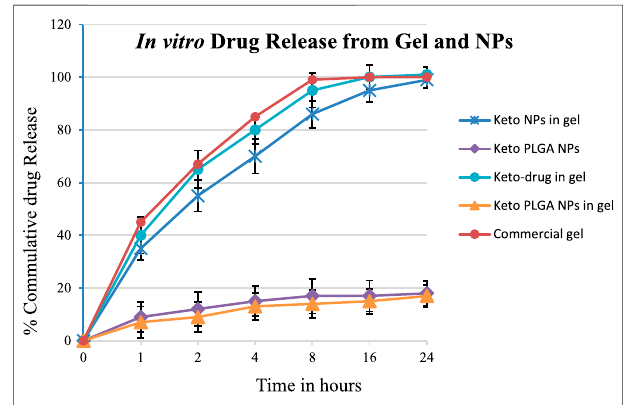
FIGURE 3 | In vitro drug release of optimized gel formulations using Franz diffusion cell and optimized NPs formulation (12.5% keto + 87.5% PLGA NPs). Mean ± standard deviation ( n = 3).